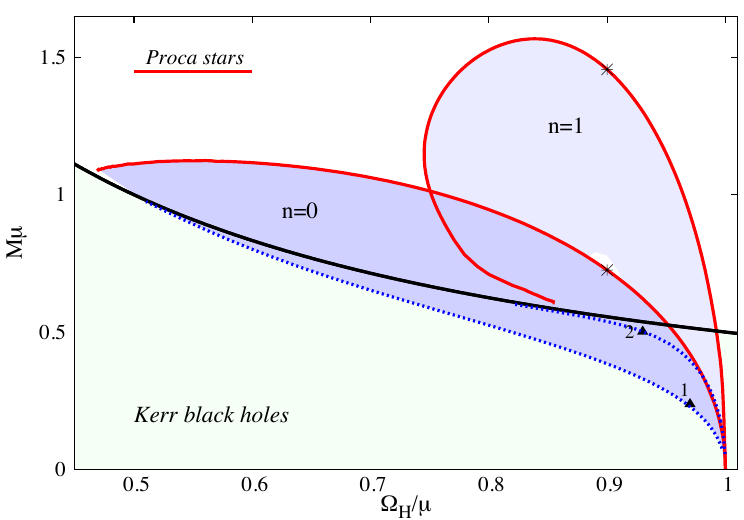
Figure 3 . Domain of existence of the n = 0 (fundamental state) and n = 1 (excited state) BHs with synchronised Proca hair with m = 1 in an ADM mass vs. angular velocity diagram, in units of (cid:22) . The black solid line corresponds to extremal Kerr BHs; non-extremal Kerr BHs exist below that line, in the light green shaded region. Two Proca star solutions and two hairy BH solutions were highlighted (as stars and triangles), to be analysed in section